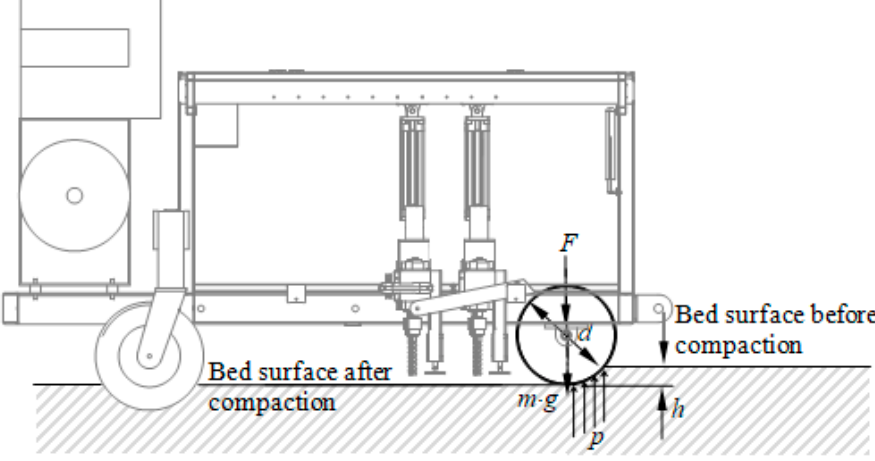
Figure 7. Free body diagram of the roller.